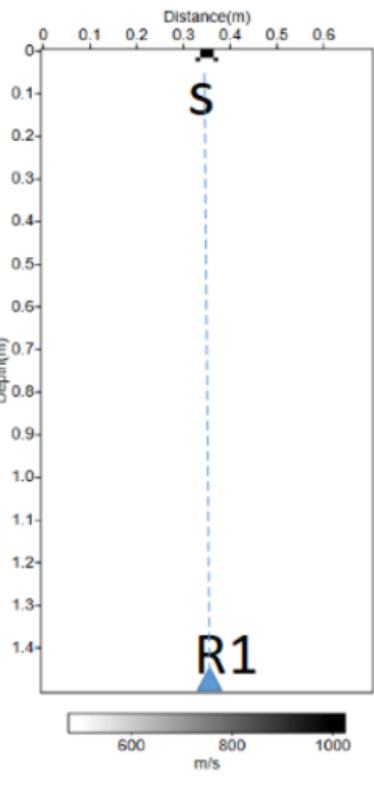
Figure 2. Physical velocity model in the case of the propagation of the full wavefield by finite differences with one propagation medium. S indicates the source at the surface. R 1 is the first